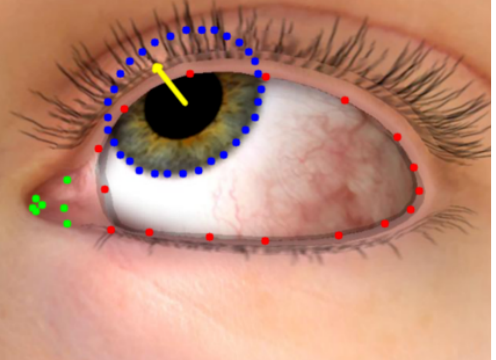
Figure 8. An annotated sample from UnityEyes. The red, green, and blue points are 16 eye edges, 7 caruncles, and 32 iris edges, respectively. The yellow arrow represents the 3D gaze direction.